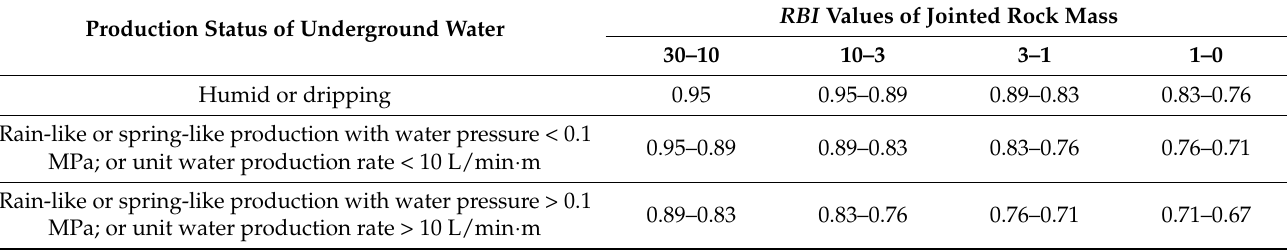
Table 4. Recommended values for the correction factor λ to capture the effects of underground water on the weathering conditions of rock mass.